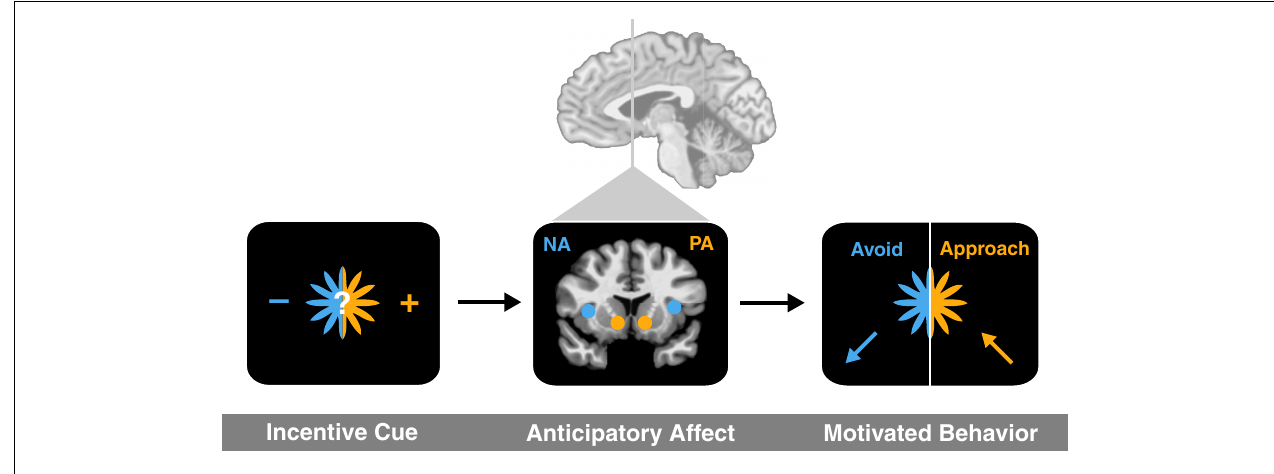
with anticipatory affect (positive arousal and negative arousal, respectively). The balance of activation in related circuits then promotes either approach toward or avoidance of